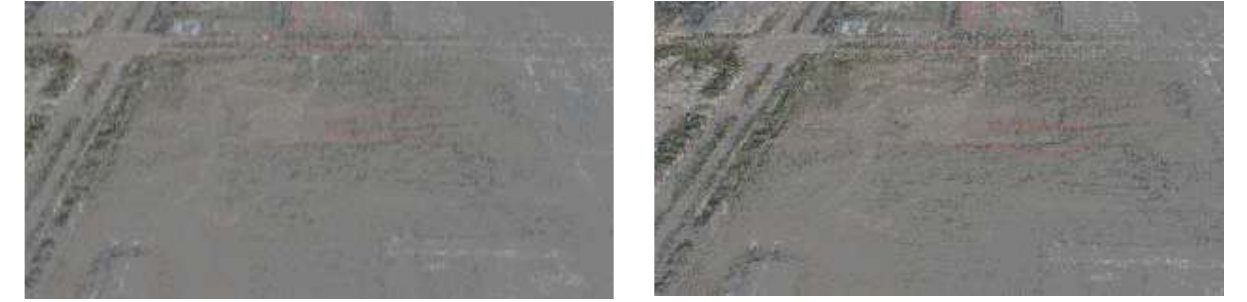
Figure3. Comparison of point cloud reconstruction generated by different methods